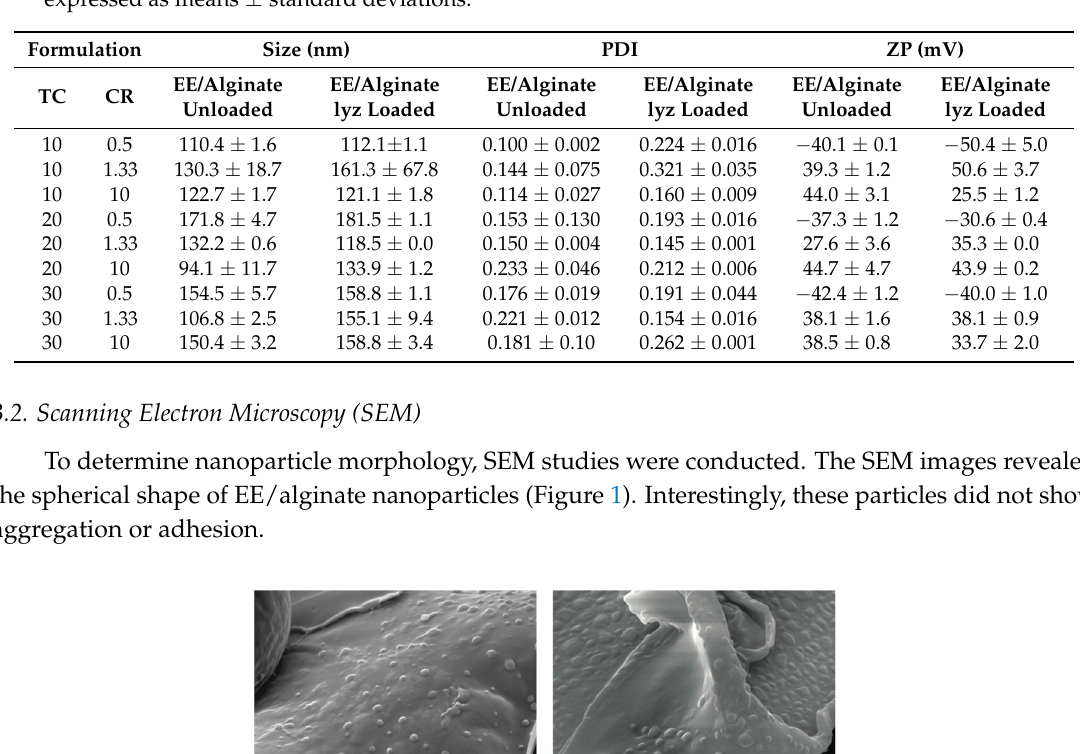
Figure 2. FTIR Spectra of pure materials and Lys-loaded pNP CT 20 and RC 0.5 showing characteristic peaks of each separate material and no evidence of covalent interactions among Lys and materials, supporting the electrostatic interactions that sustain the polymeric system.